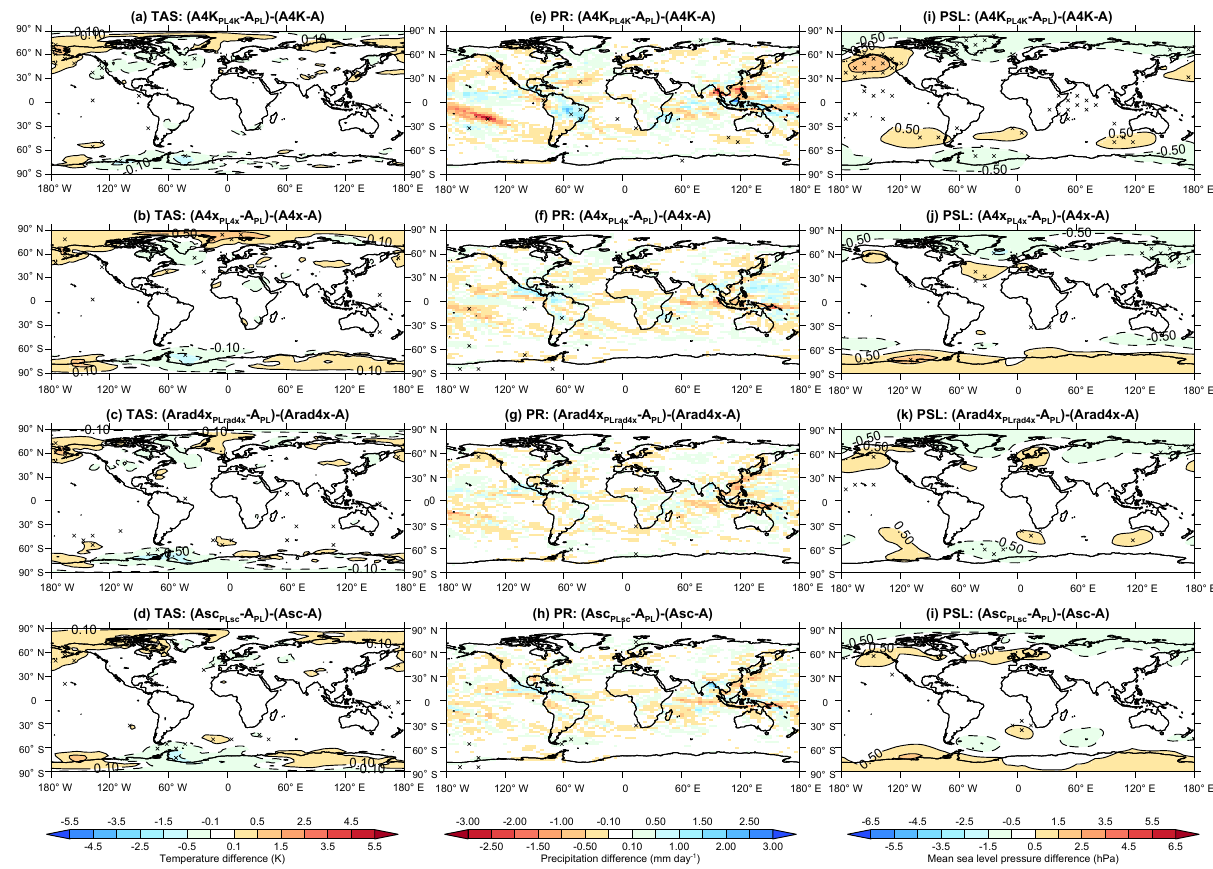
Figure 2. Differences in surface air temperature (TAS, K) for (a) (A4K PL4K minus A PL ) minus (A4K minus A), (b) (A4x PL4x minus A PL ) minus (A4x minus A), (c) (Arad4x PLrad4x minus A PL ) minus (Arad4x minus A), and (d) (Asc PLsc minus A PL ) minus (Asc minus A). Equivalent differences between simulations are given in panels (e–h) and (i–l) for precipitation (PR, mmday − 1 ) and mean sea level pressure (PSL, hPa), respectively. The points labelled with an “x” indicate the differences are statistically significant using Student’s t test ( p ≤ 0 .